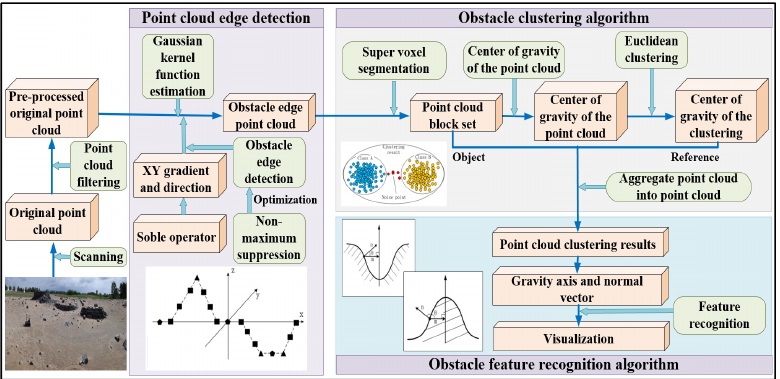
Figure 1. The proposed novel approach to obstacle detection in unstructured